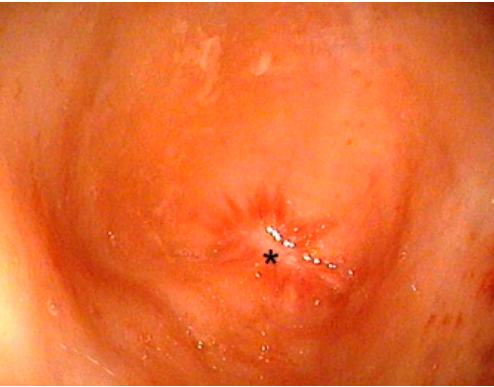
Figure 3. Star-shaped end of the rectal pouch marking the future tract towards the sphincter complex (*).